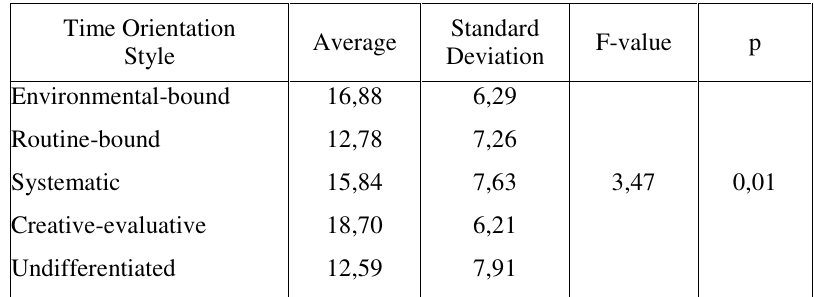
ANALYSIS OF VARIANCE FOR TIME ORIENTATION STYLE AND RELATIVELY COMPLEX-DYNAMIC